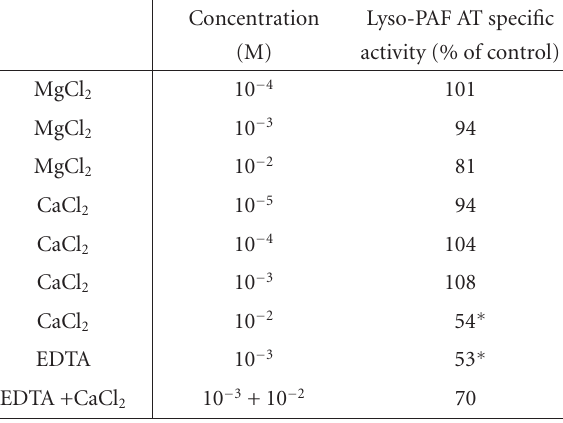
Table 3. E ff ect of divalent cations and chemicals on TM lyso- PAF AT activity. Results are the average of two independent de- terminations using di ff erent enzyme preparations performing duplicate